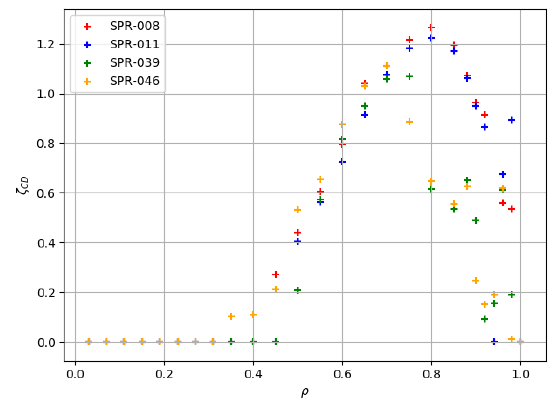
Figure 3. Maximum 𝜁 𝐶𝐷 vs ρ of the peak in the driven current density for each SPR.